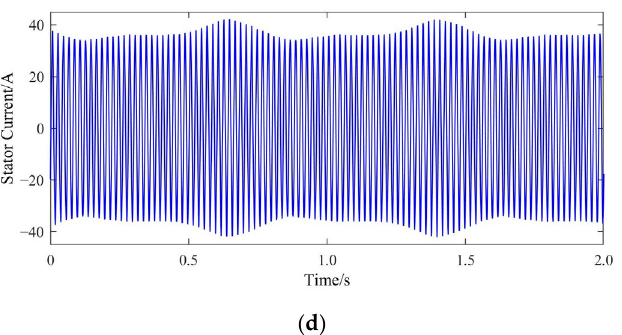
Figure 5. Stator phase A current: ( a ) normal; ( b ) one broken bar; ( c ) two broken bars; ( d ) three broken bars.